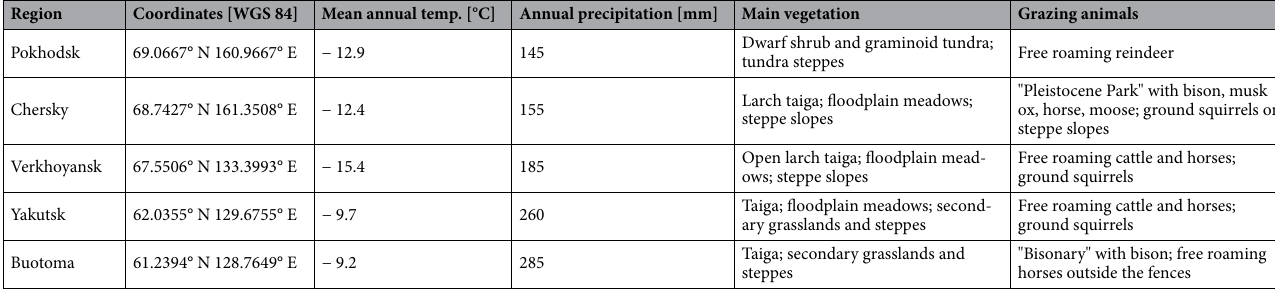
Table 1. Overview on study regions. Climate data according to WorldClim 56